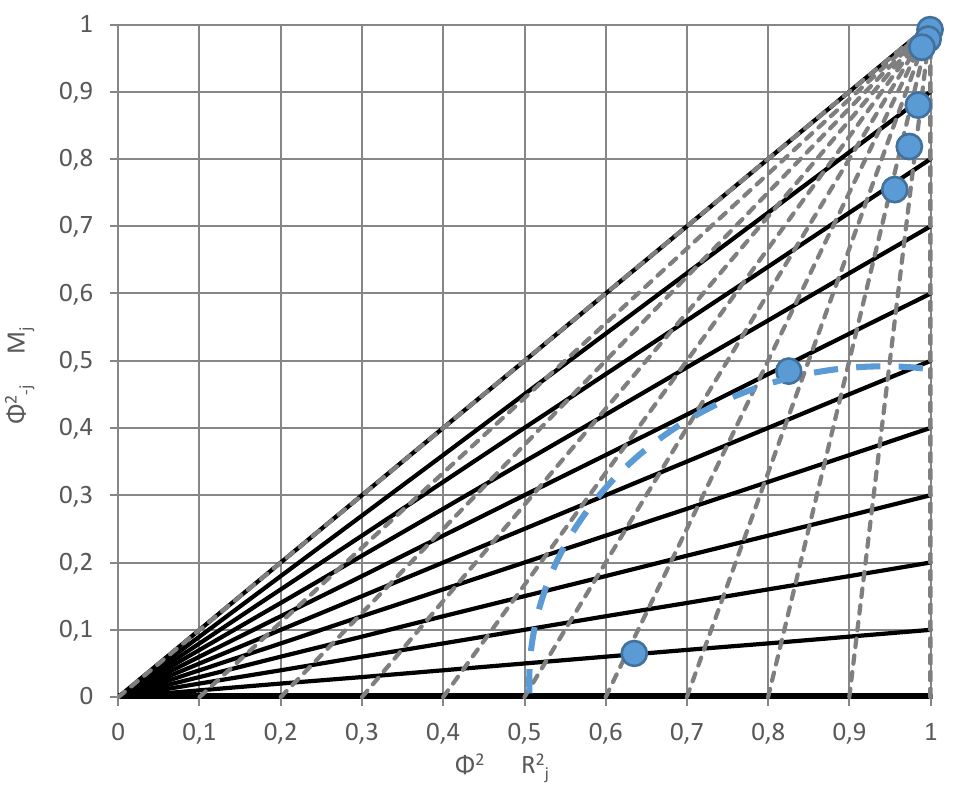
Figure 2. Trends of cumulative characteristics when gradually eliminating